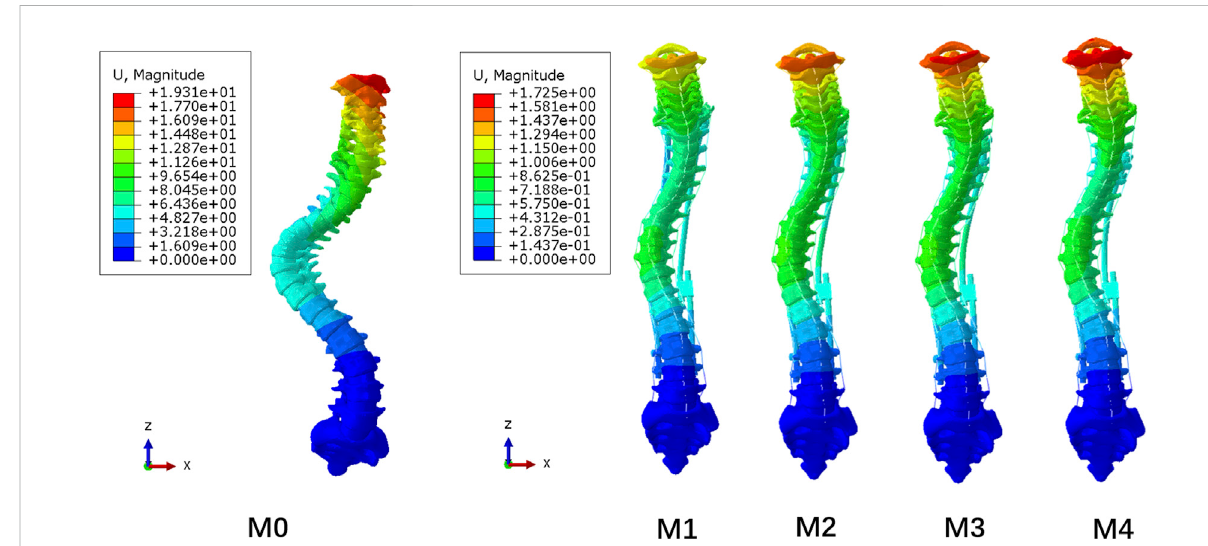
FIGURE 5 Displacement nephogram of M0 – M4